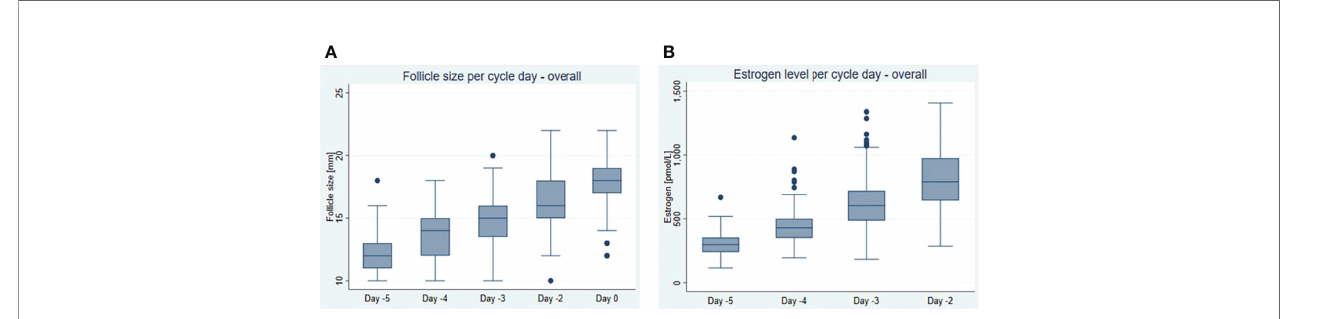
FIGURE 1 | Dynamics of (A) follicular growth expressed as follicle size per day and (B) oestrogen (E2) increase expressed as oestrogen concentration per day in natural cycles within the last 5 days before follicle aspiration (day 0 = day of oocyte retrieval). Box and and whisker plot shows median, interquartile range, maximum, minimum